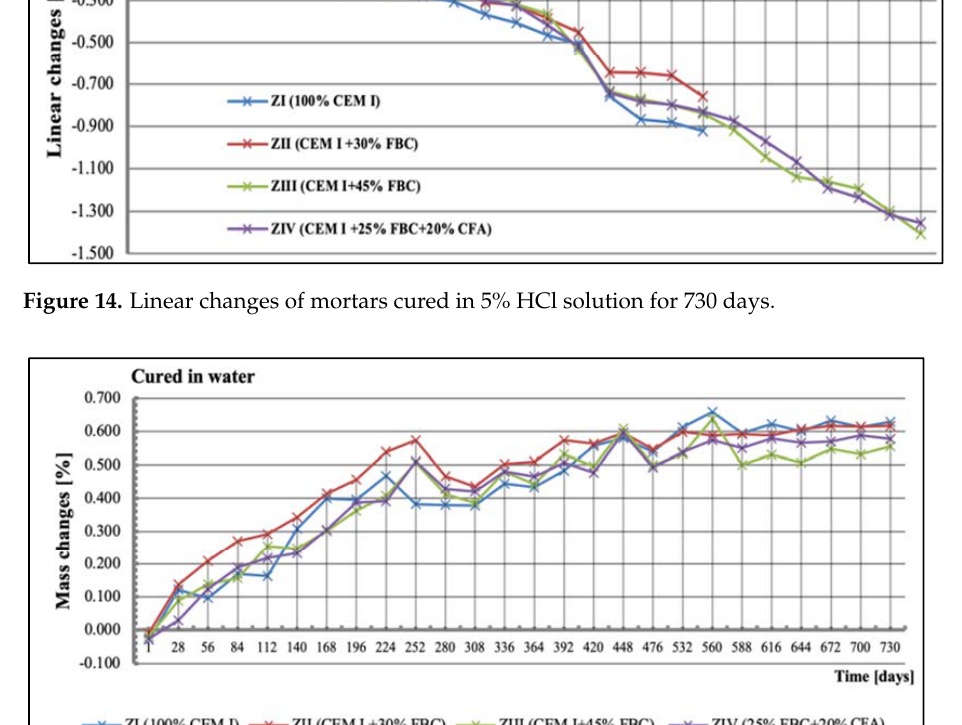
Figure 15. Mass changes of mortars cured in water for 730 days.